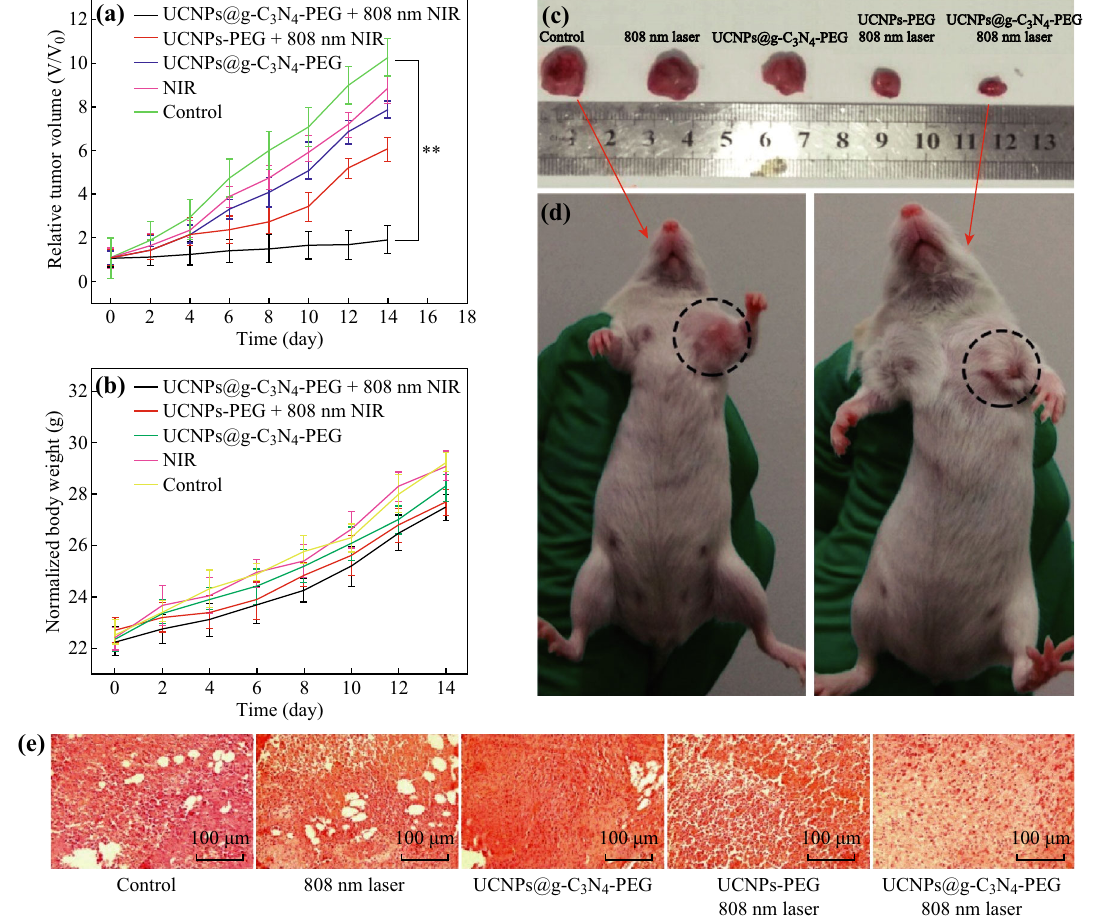
Fig. 9 a In vivo tumor volume growth curves of mice in different groups after various treatments. b Body weight changes of Balb/c mice versus treated time under different conditions. c Photographs of excised tumors from representative Balb/c mice after 14 day treatment and d the corresponding digital photographs of mice in the control group and ‘‘UCNPs@g-C3N4 - PEG with 808 nm laser’’ group after 14 day treatment. e H&E stained tumor sections after 14 day treatment from different groups. Reproduced with permission from Ref. [118] Copyright 2016 American Chemical